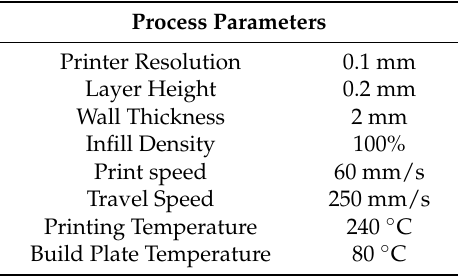
Table 1. Process parameters for 3D